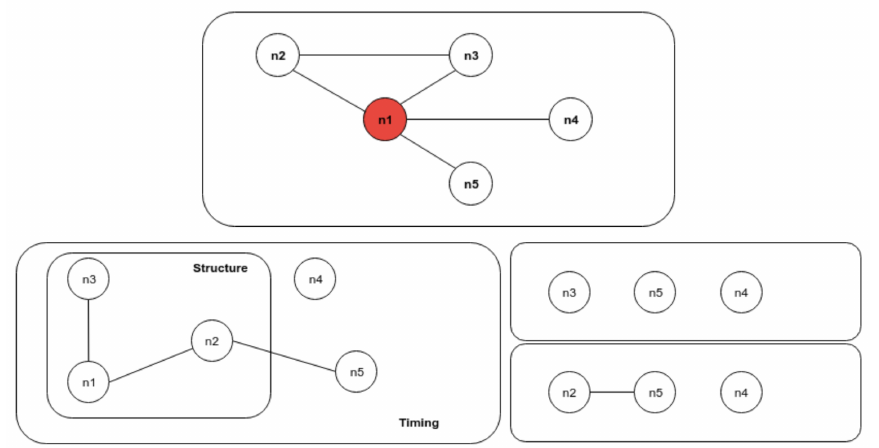
Figure 7. Timing issue of the matching process. ( Upper ) The matching conditions among active nodes in the market; ( Bottom ) different market states caused by different node N i ’s matching